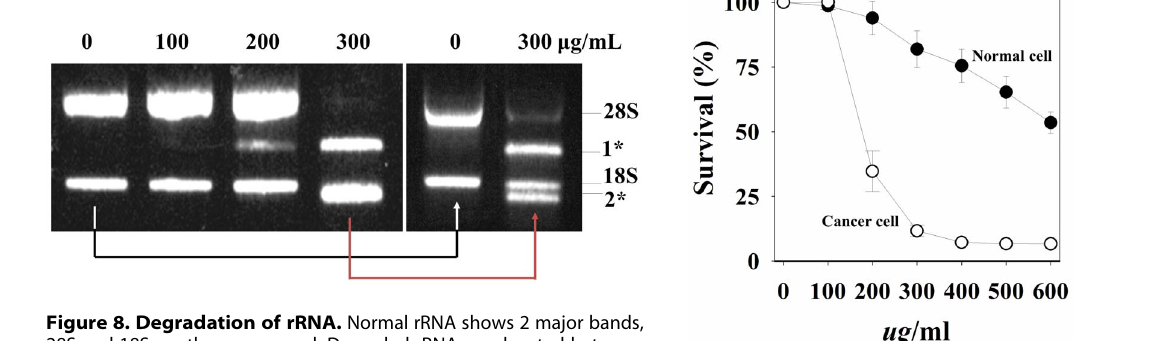
Figure 8. Degradation of rRNA. Normal rRNA shows 2 major bands, 28S and 18S, on the agarose gel. Degraded rRNAs are located between the 28S and 18S rRNA bands (designated as ‘‘1’’) and below (designated as ‘‘2’’) the 18S rRNA. In order to investigate the atypical band seen for 300 m g/mL MOL-treated cells in the left panel, more dilute rRNA was separated by gel electrophoresis.